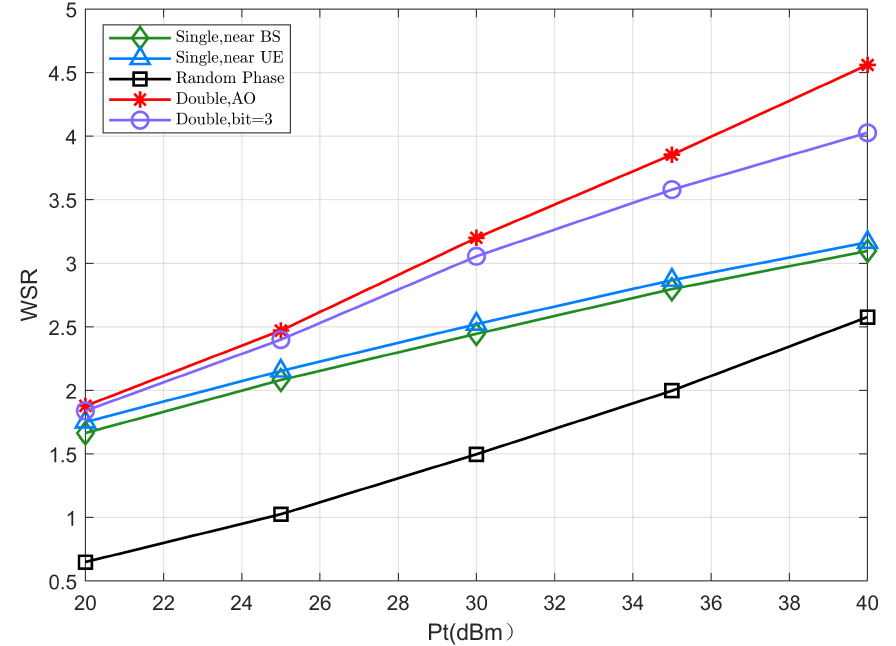
Figure 4. The WSR versus the transmit power P t .